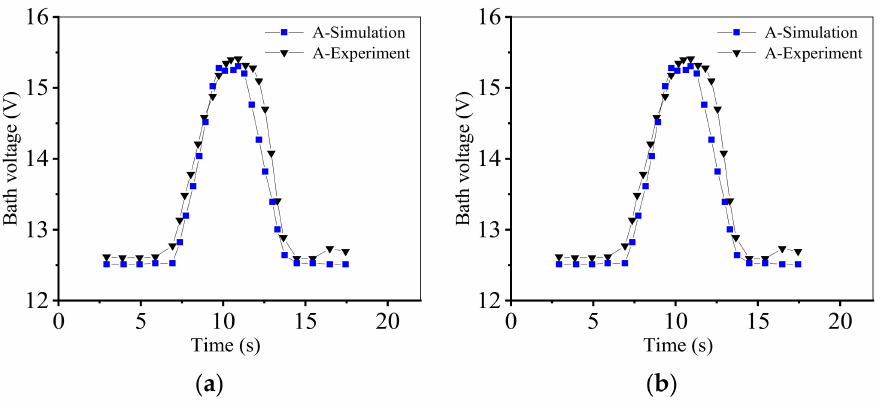
Figure 8. Law of the brush plate slot voltage variation with time. ( a ) A-brush plate; ( b ) B-brush plate.